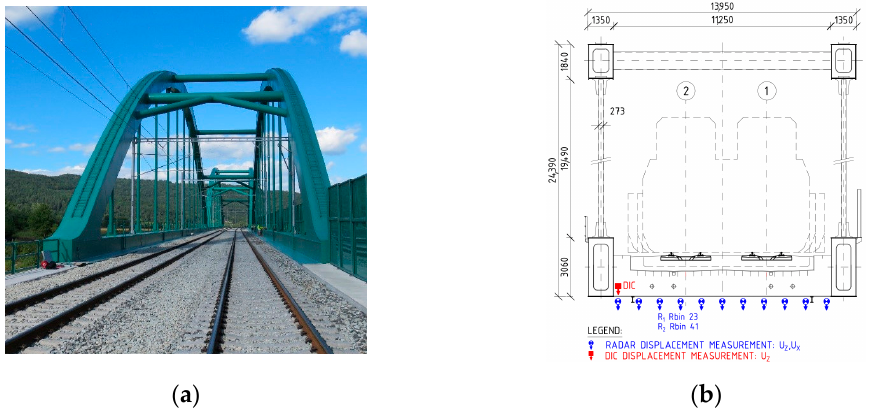
Figure 18. View on the analyzed horizontal load-bearing structure BS2 that is oriented in the direction of its longitudinal axis ( a ) photo; in the background there is the superstructure BS3; ( b ) schematic with marked positions of DIC target, and Rbins.